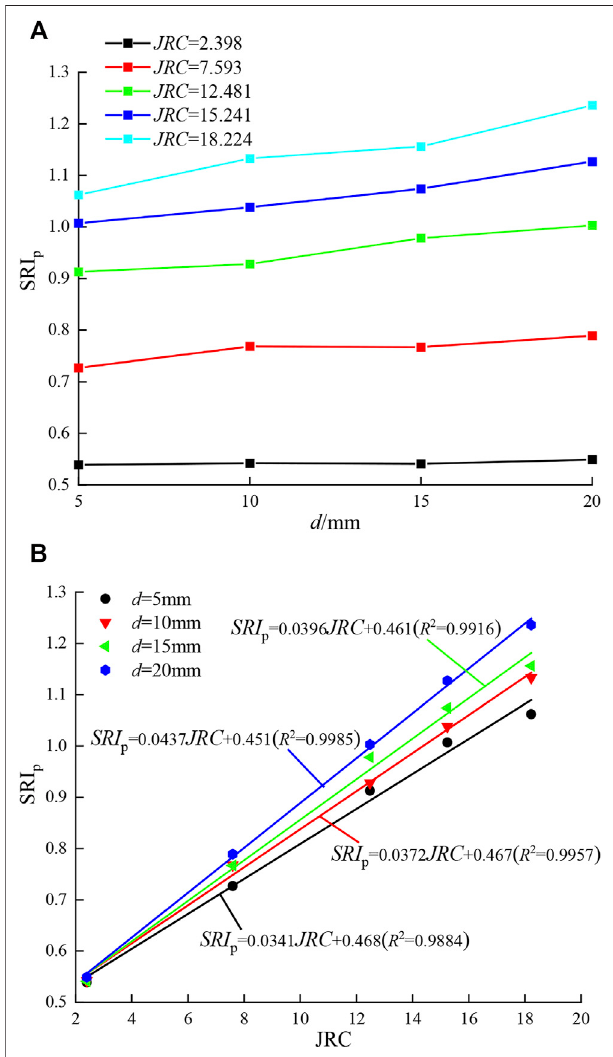
FIGURE16| VariationofSRI p with d andJRC. (A) d -SRI p . (B) JRC-SRI p .